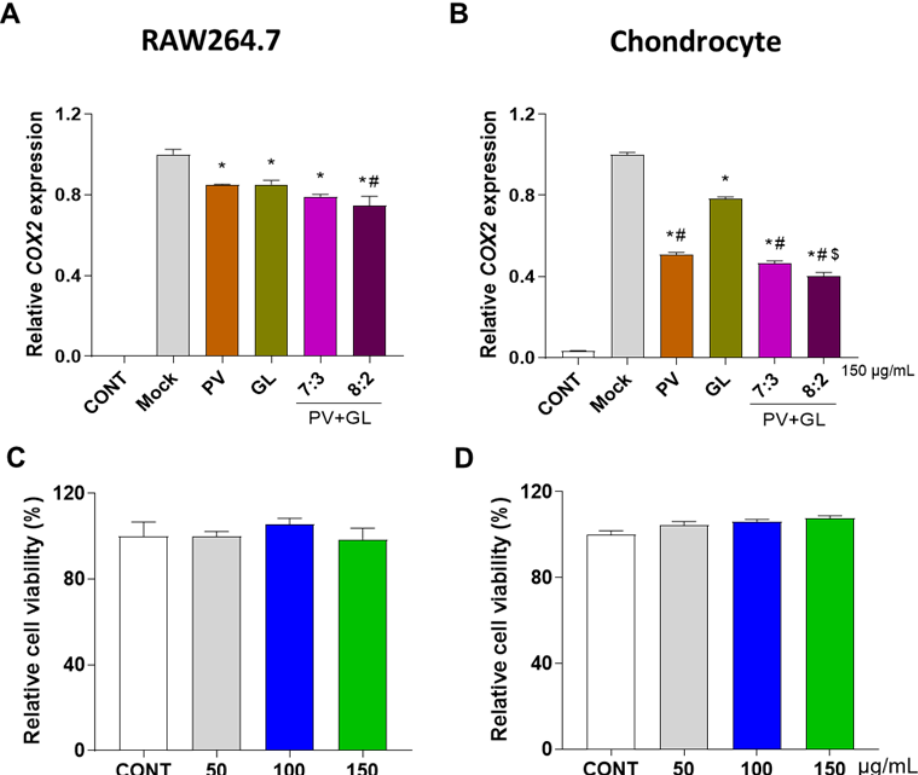
Figure 1. Effects of PV and GL extract on Raw 264.7 cells and primary chondrocytes. RAW 264.7 cells were incubated individually with PV and GL extract and their combined mixture (PG extract) with different ratios (7:3 and 8:2) for 24 h. Primary chondrocytes were incubated individually with PV and GL extract and their combined mixture (PG extract) with different ratios (7:3 and 8:2) for 48 h. ( A , B ) Relative COX2 expression was determined by qRT-PCR. ( C , D ) Cell viability was examined by WST assay. * p < 0.05 vs. Mock, # p < 0.05 vs. GL, $ p < 0.05 vs. PV. CONT; non-treated group, PV; Prunella vulgaris extract, GL; Gentiana lutea extract.